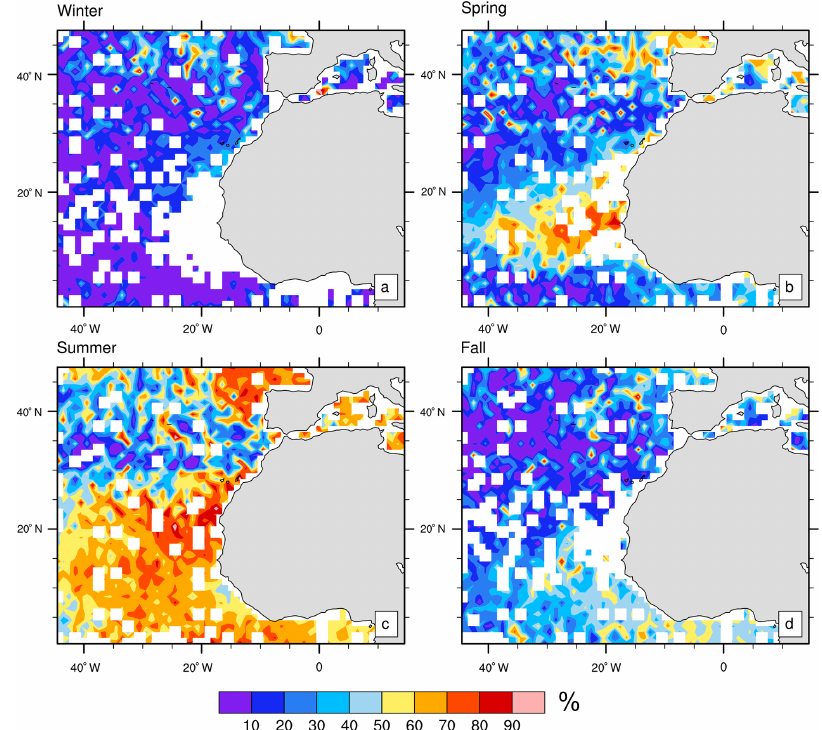
Figure 10. Amount of dust (%) above marine stratocumulus clouds in (a) winter, (b) spring, (c) summer, and (d)